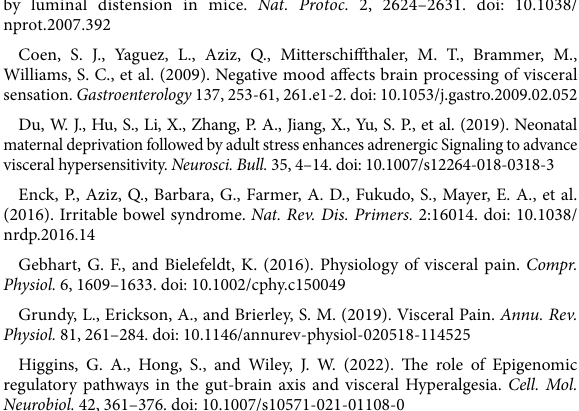
SUPPLEMENTARY FIGURE S3 The flowchart of bibliometric